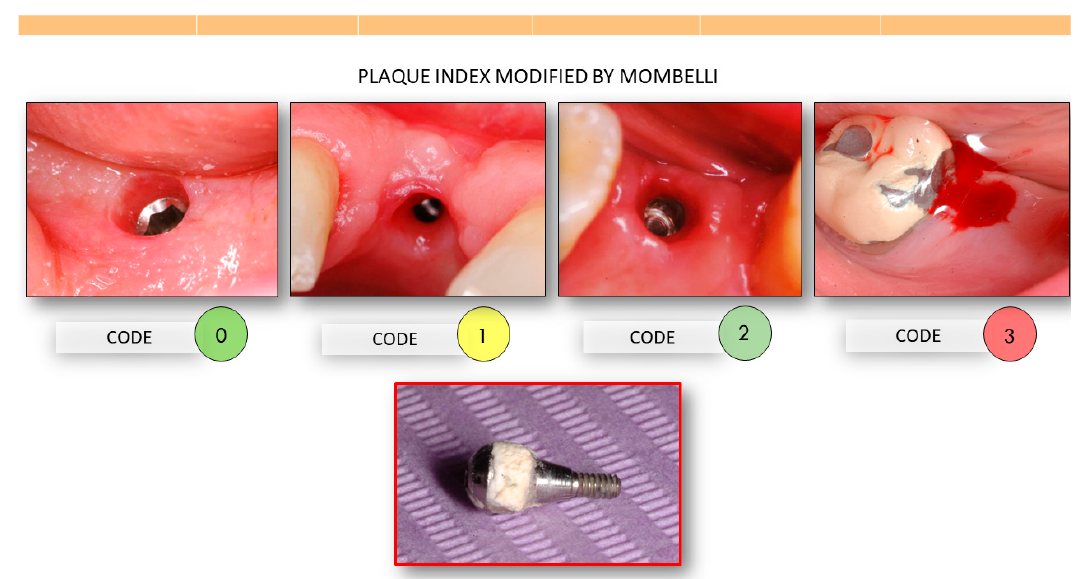
Figure 2. Degree of inflammation of the peri-implant mucosa evaluated immediately after the disengagement of the healing abutment, codified with plaque index modified by Mombelli, being Code 0: gingiva without inflammation and pale pink color; Code 1: gingiva erythematous without bleeding upon manipulation; Code 2: gingiva bleeds slightly during unscrewing or screwing of the abutment; Code 3: gingiva bleeds profusely during unscrewing or screwing of the abutment. The degree of plaque accumulation on the abutment was recorded following the modified Mombelli plaque index [35].